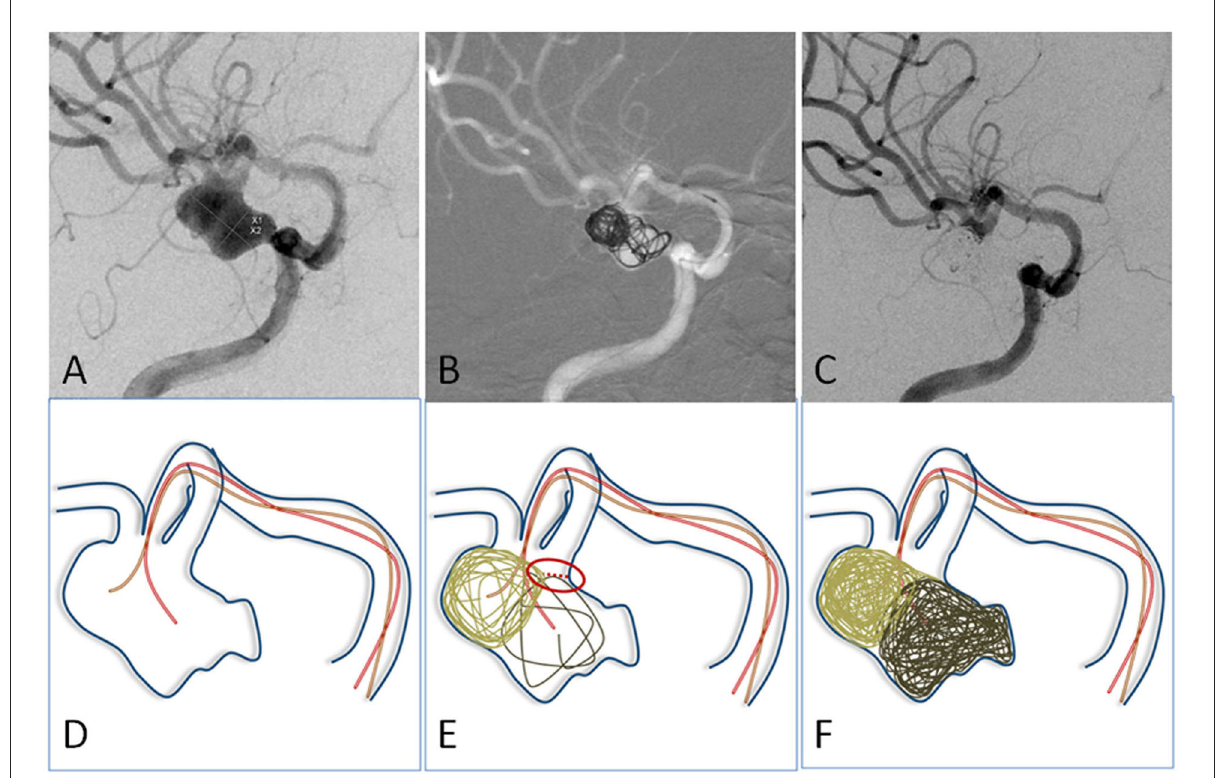
FIGURE2 (A) The angiographic imaging showed an MCA aneurysm with lateral growth. (D) Illustration: Two microcatheters with different curves were navigated into different portions of the aneurysm. (B,E) The first two coils were advanced into aneurysms through two microcatheters to form a stable frame. They supported and embraced each other. (C,F) The aneurysm was embolized with neck